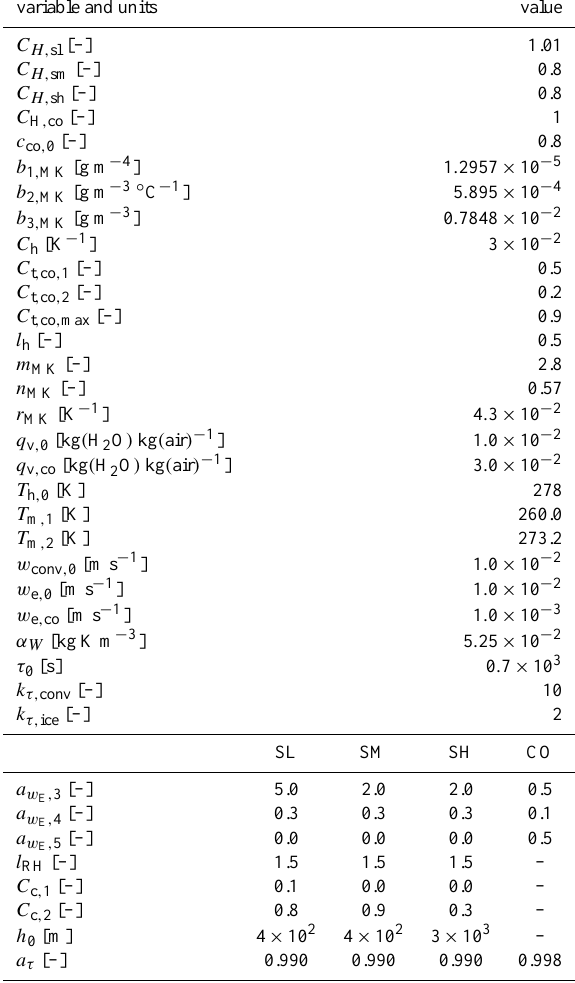
Table 2. List of the standard values of the governing parameters of the scheme. Long dash in the first column indicates that the cor- responding variable is non-dimensional, and in the last column it shows that a specific parameter is not applied to cumulus clouds. variable and